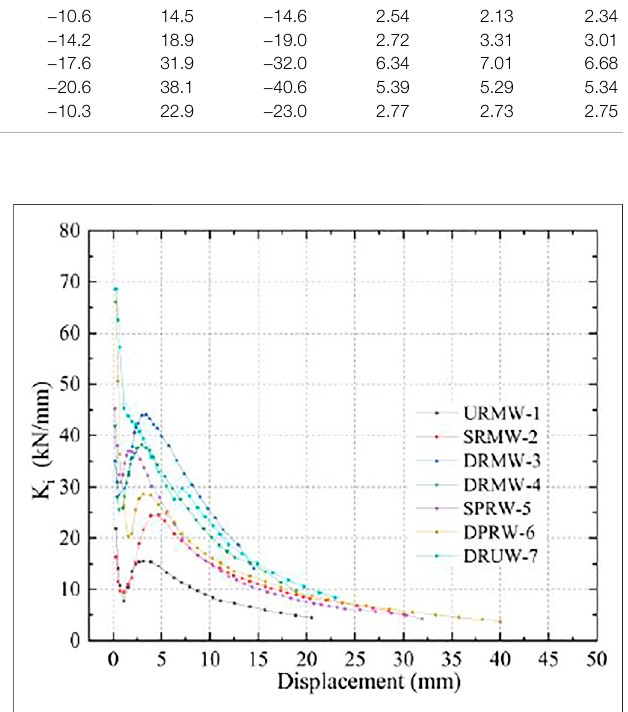
FIGURE 12 | Stiffness degradation